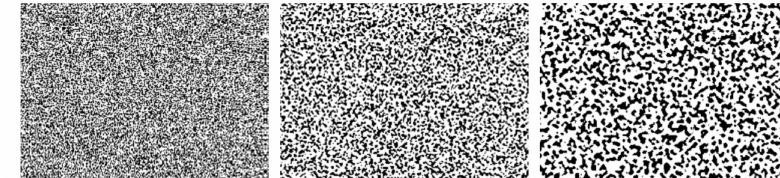
Figure 1. Stochastic patterns of different